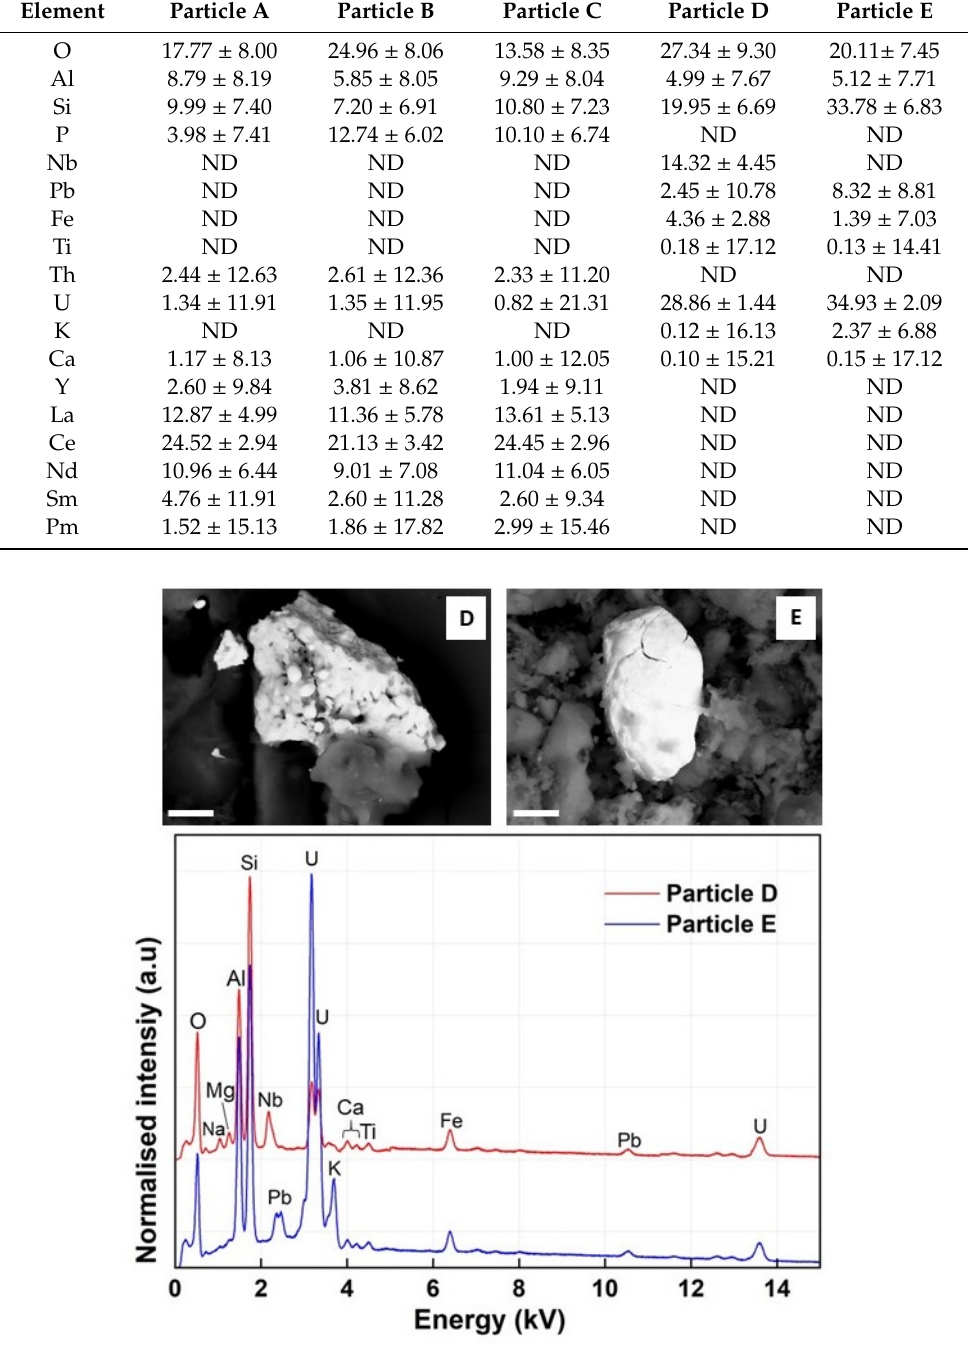
Figure 3. (Top) backscattered electron images of two uraninite particles ( D in Okaba coal ash and E in Omelewu coal ash). (Bottom) associated EDS spectra with emission peaks identified (scale bars = 5 μ m).